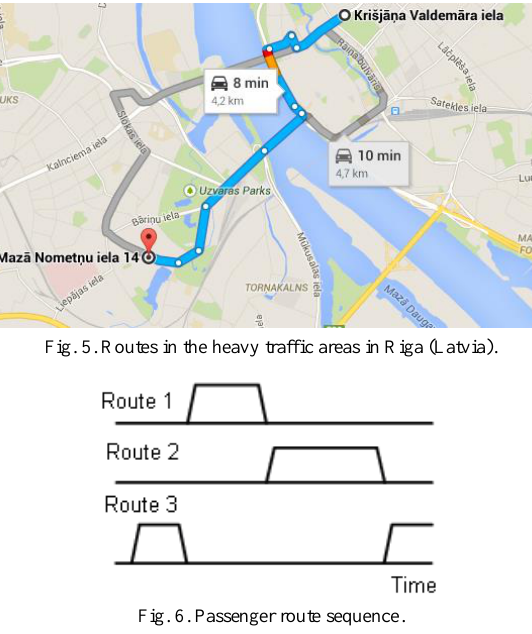
Fig. 6. Passenger route sequence.